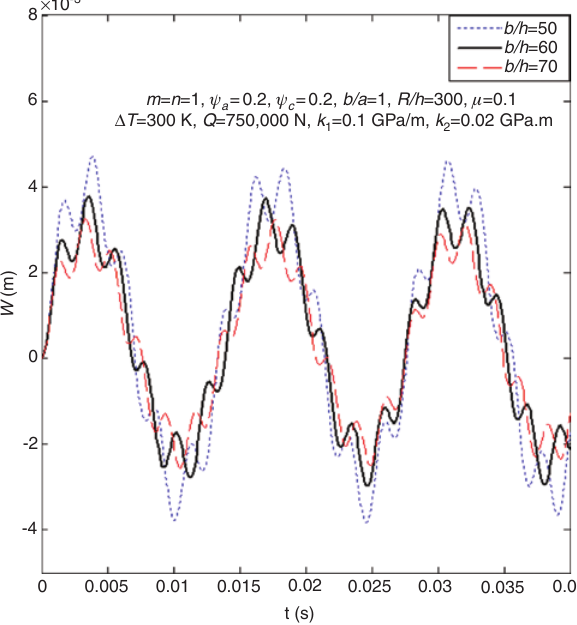
on the dynamic a Figure 5: Effect of the b / h ratio on the non-linear dynamic response of the polymer composite cylindrical